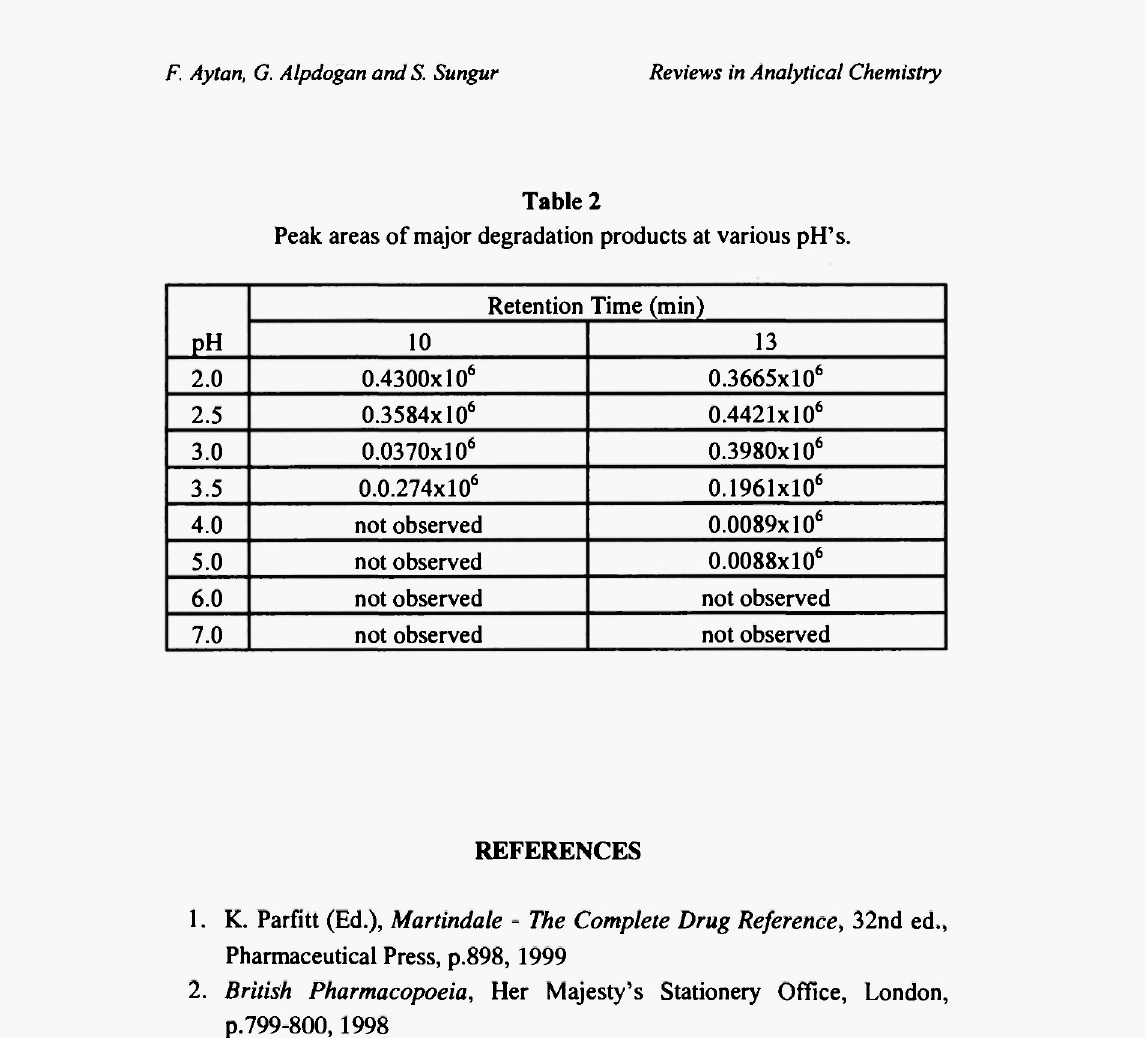
Peak areas of major degradation products at various